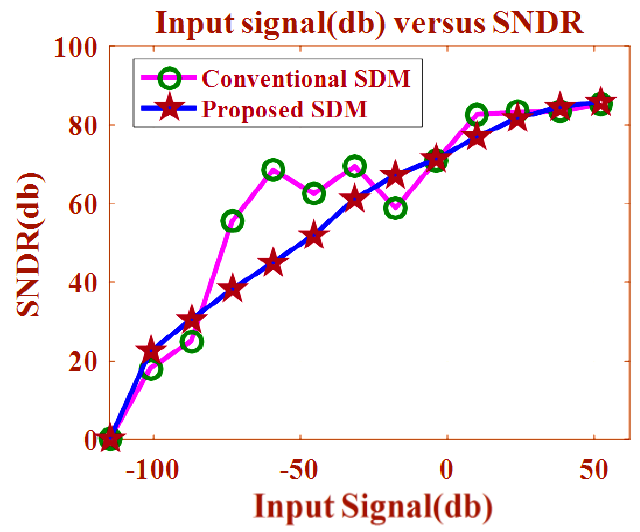
Figure 17. SNDR vs. Input signal.